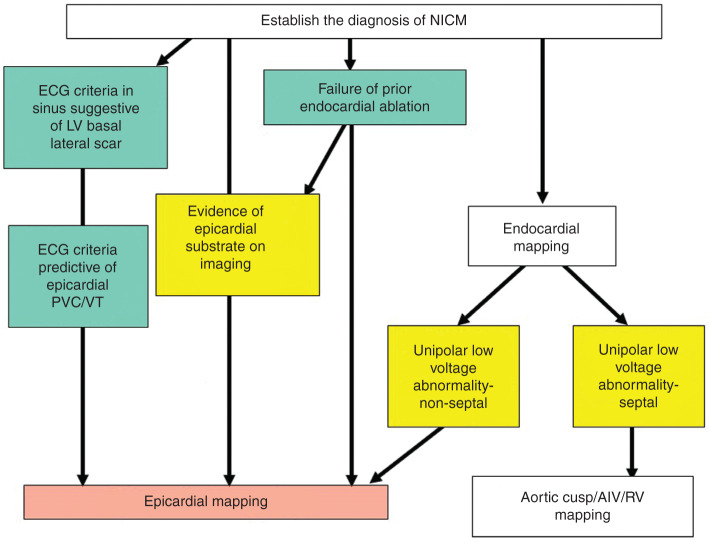
A VT ablation approach in patients with NICM. This figure represents a flow chart and a potential approach in patients with NICM who undergo catheter ablation for VT. The ECG criteria during sinus rhythm that predict the presence of LV basal lateral scar include an R-wave in lead V1 ≥ 0.15 mV and an S-wave in lead V6 ≥ 0.15 mV.76 This can be distinguished from patients with prior inferior/inferolateral myocardial infection by (1) lateral lead QRS fragmentation, (2) a lack of inferior Q waves, and (3) a lead V6 S/R ratio of ≥ 0.25.77 These findings may be useful in predicting the presence of LV scar and in determining the risk of VT in patients with NICM. The ECG criteria predictive of an epicardial exit during ventricular arrhythmias (ie, PVCs, VTs) are summarized in Table 2. Epicardial mapping may be considered in selected patients when (1) the 12-lead ECG of the VT suggests an epicardial origin; (2) there is evidence of epicardial substrate on imaging studies (eg, MRI, intracardiac echocardiography); (3) there is unipolar electrogram voltage abnormality; and (4) there is failure of prior endocardial ablation. The important decision steps are highlighted in yellow. AIV: anterior interventricular vein; ECG: electrocardiogram; LV: left ventricle; MRI: magnetic resonance imaging; NICM: nonischemic cardiomyopathy; PVC: premature ventricular complexes; RV: right ventricle; VT: ventricular tachycardia.